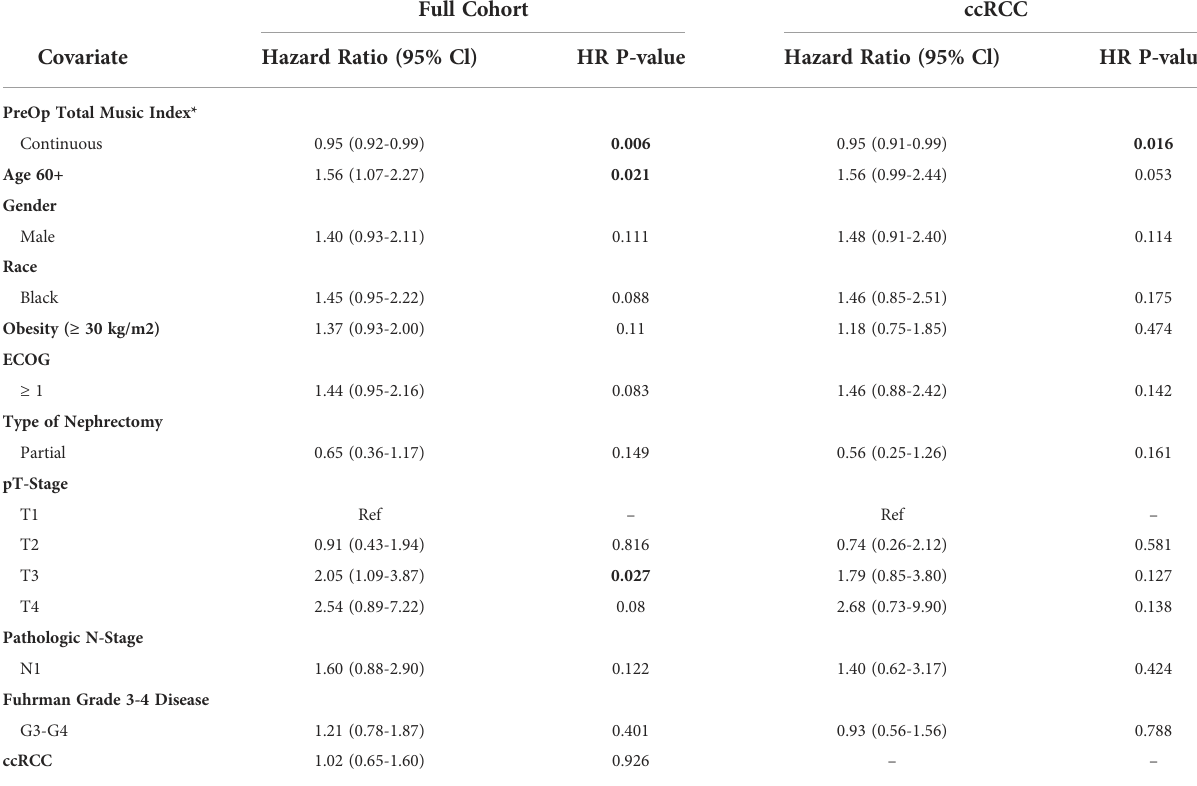
TABLE 3 Multivariable model summary of COX hazard overall survival for continuous preoperative linear muscle